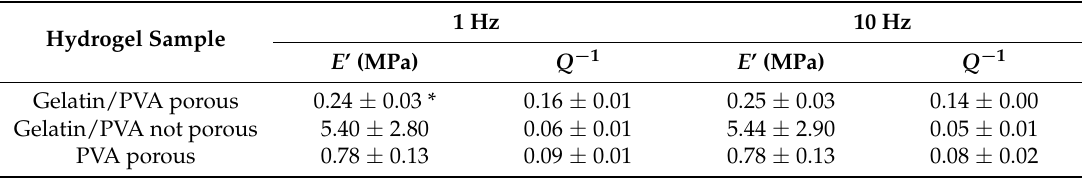
Table 1. Compressive storage modulus ( E ’) and loss factor ( Q − 1 ) of the hydrogels calculated at 1 Hz and 10 Hz of